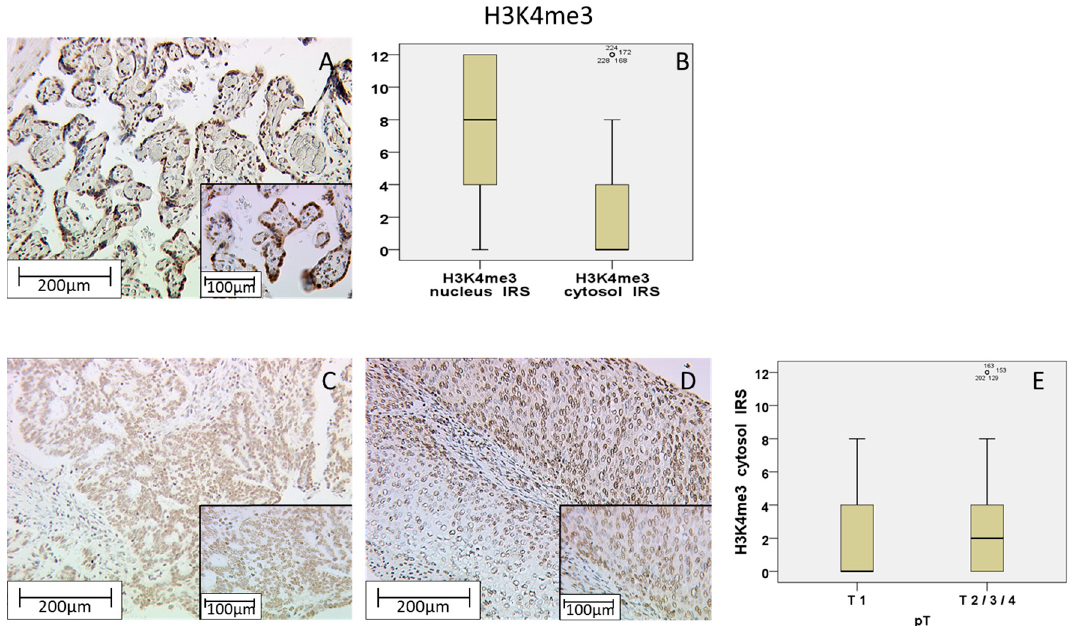
Figure 2. Positive control of H3K4me3 staining in placenta tissue with strong nuclear cytoplasmic expression and weak cytoplasmic expression in trophoblastic cells ( A ); H3K4me3 showed a higher expression in the nucleus than in the cytoplasm ( B ); T1-stage tumors ( C ) with significantly lower expression than T2/3/4-stage tumors ( D ); The summary regarding T-status is shown as a box plot ( E ). Scale bar 200 µm, small pictures 100 µm.